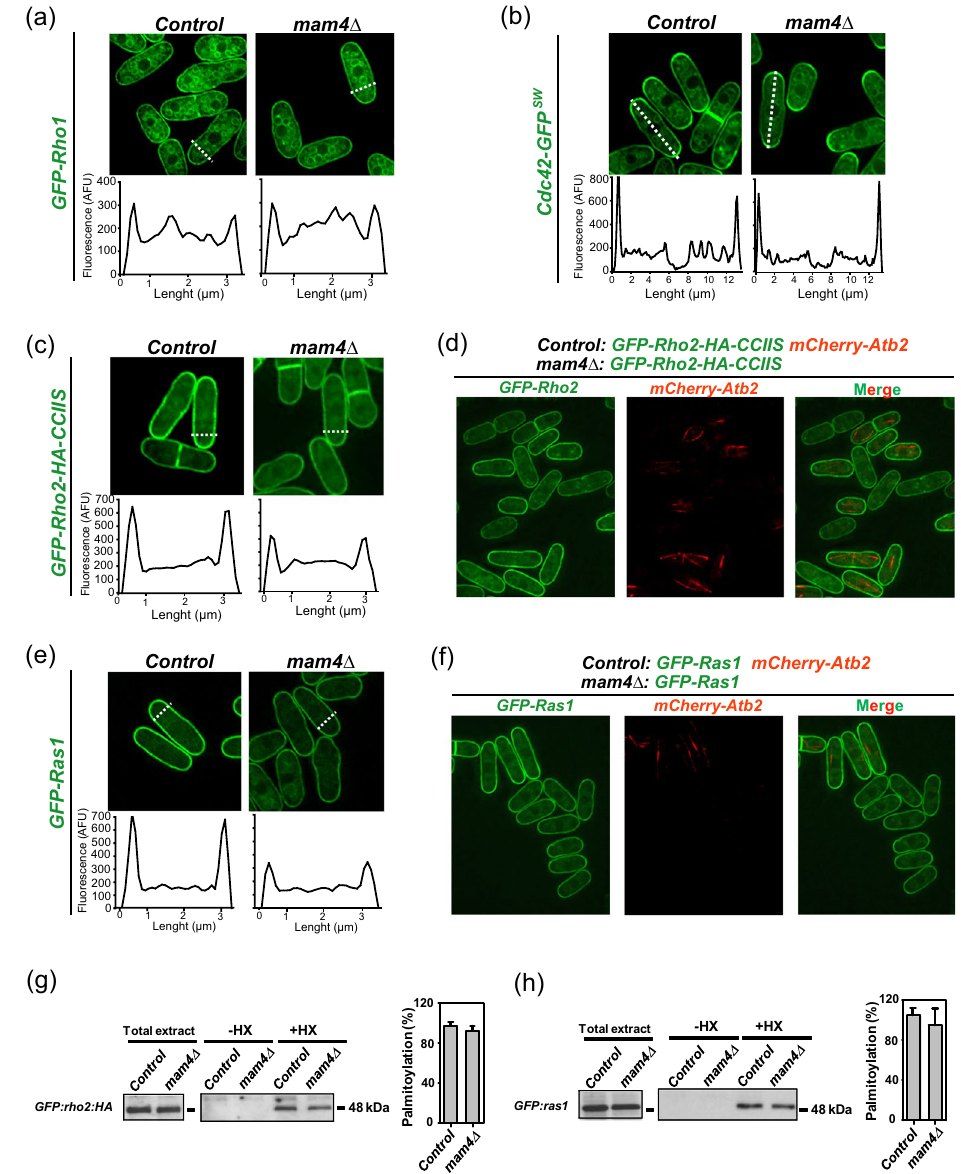
Figure 2. Mam4 function differentially affects GTPase localization at the plasma membrane. ( a ) Deconvolved images of cells from control and mam4 ∆ strains expressing GFP-Rho1 fusions grown in YES medium and observed by fluorescence microscopy. Representative fluorescence intensity plots (as arbitrary fluorescence units) were generated from line scans across the cell width (dotted white lines). ( b ) Images of cells from control and mam4 ∆ strains expressing Cdc42-GFP SW genomic fusions observed by fluorescence microscopy. Representative fluorescence intensity plots were generated from line scans across the cell length (dotted white lines). ( c ) Images of cells from control and mam4 ∆ strains expressing GFP-Rho2-HA-CCIIS genomic fusions observed by fluorescence microscopy. Representative fluorescence intensity plots were obtained as described in ( a ). ( d ) Deconvolved images of mixed control (GFP-Rho2-HA-CCIIS, mCherry-Atb2) and mam4 ∆ (GFP- Rho2-HA-CCIIS) cells were observed by fluorescence microscopy. ( e ) Images of cells from control and mam4 ∆ strains expressing GFP-Ras1 genomic fusions observed by fluorescence microscopy. Representative fluorescence intensity plots were obtained as described in ( a ). ( f ) Deconvolved images of mixed control (GFP-Ras1, mCherry-Atb2) and mam4 ∆ (GFP-Ras1) cells were observed by fluorescence microscopy. ( g ) Rho2 palmitoylation assayed by the acyl-biotinyl switch assay in cell lysates from control and mam4 ∆ strains expressing a GFP-Rho2-HA genomic fusion. Biotinylation is specific for proteins containing a free sulfhydryl generated after hydroxylamine cleavage ( + HX). Total extracts from the strains were included as loading controls. GFP-Rho2-HA fusion was detected employing anti-HA antibody. Percentage of palmitoylation (as mean ± SD) in control and mam4 ∆ cells was determined from biological duplicates. ( h ) Ras1 palmitoylation by the acyl-biotinyl switch assay in control and mam4 ∆ strains expressing a GFP-Ras1 genomic fusion was determined as above. GFP-Ras1 fusion was detected employing anti-GFP antibody. Percentage of palmitoylation (as mean ± SD) in control and mam4 ∆ cells was determined from biological